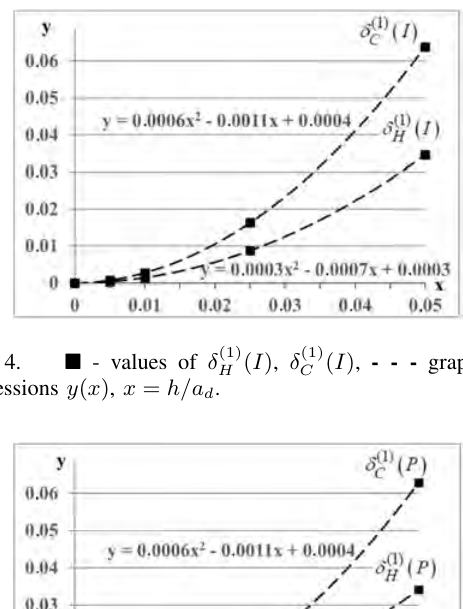
T HE SESSION TIME OF SIMULATION T s IN SECONDS ( DIAGNOSTIC SESSION TIME OF M I - CROSOFT V ISUAL C 2019), DEPENDING FROM THE x .